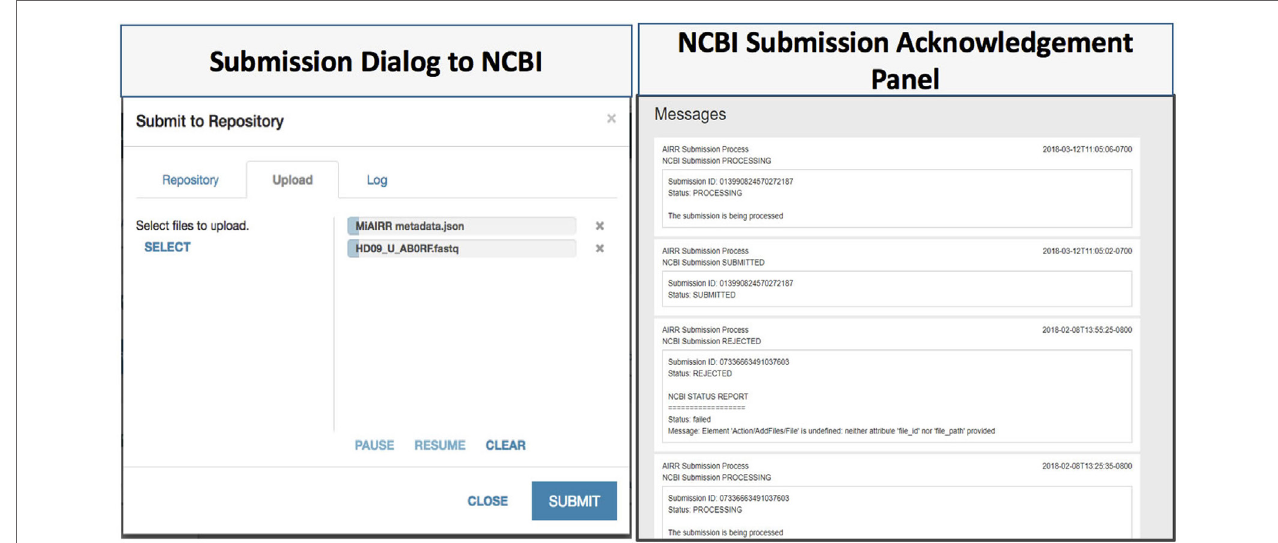
FIgURe 4 | CAIRR data submission. (1) Data submitters choose National Center for Biotechnology Information (NCBI) Sequence Read Archive (SRA) as the target repository, and then upload the related datasets to submit. (2) CAIRR provides submission acknowledgment and data-processing-level messages generated by the NCBI